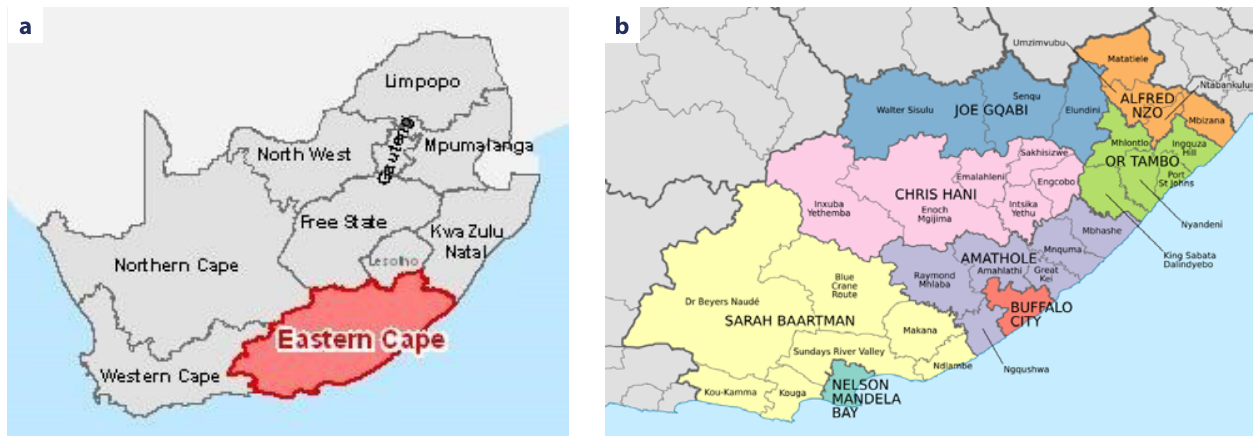
Figure 1: (a) Map of Eastern Cape Province; (b) Eastern Cape Province with its